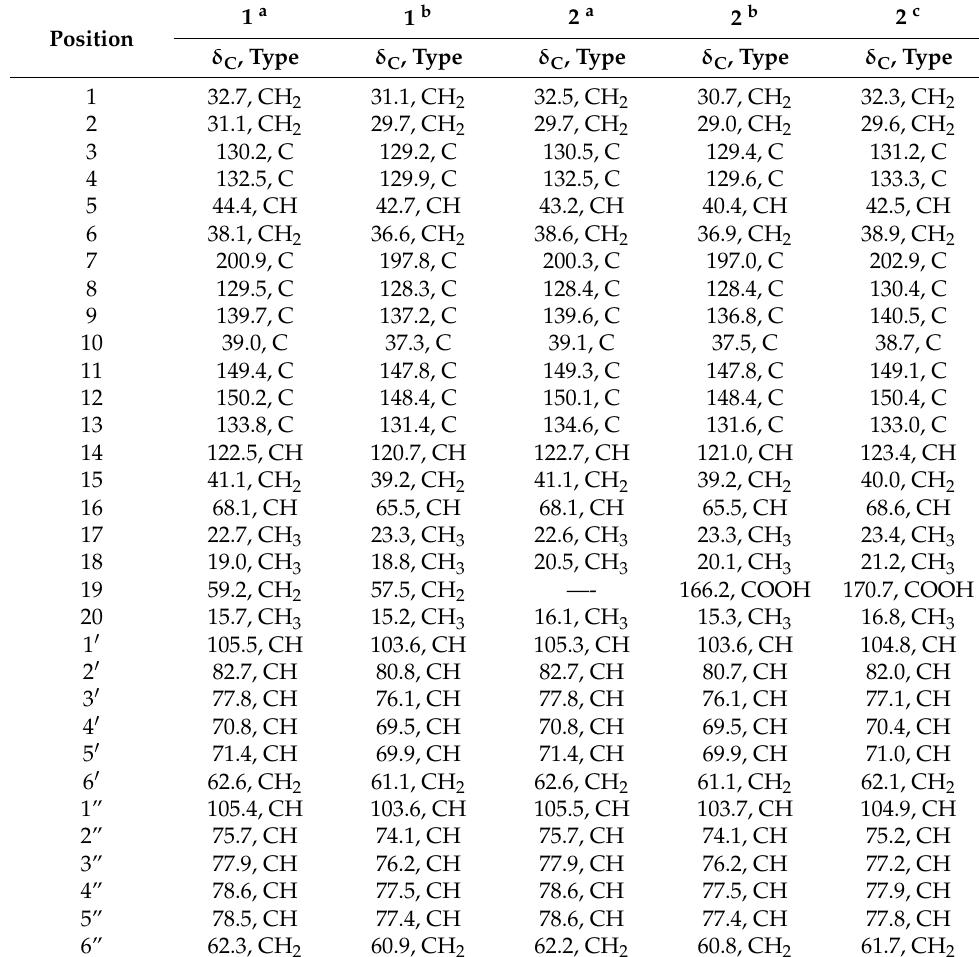
Table 2. 1D- 13 C NMR (150 MHz) spectroscopic data for compounds 1 and 2 .